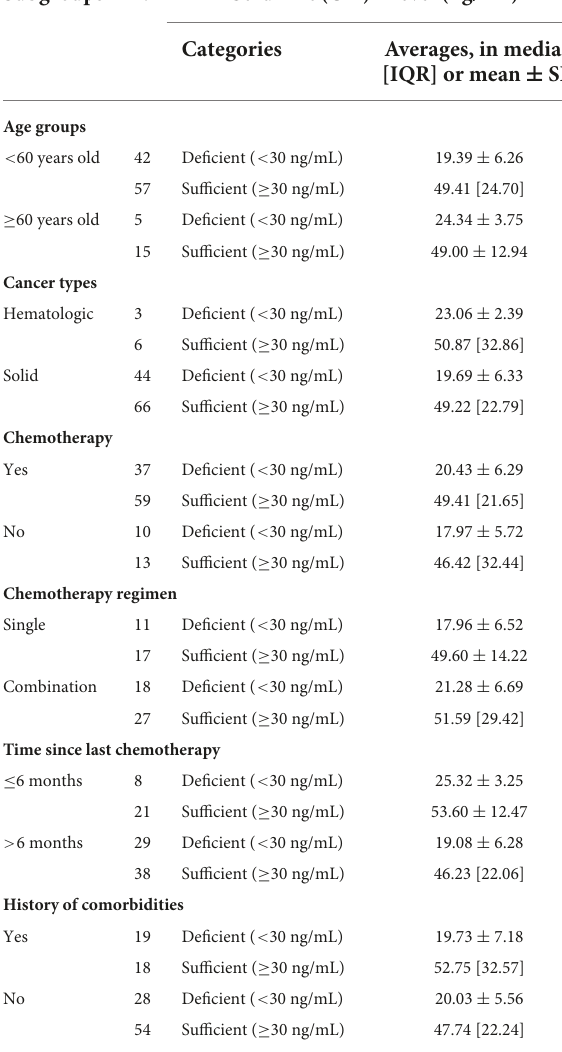
TABLE 2 Vitamin D levels based on the subjects